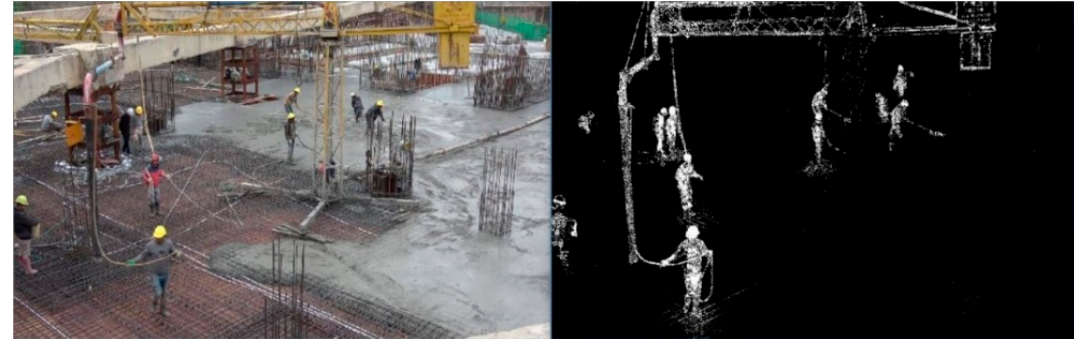
Figure 5. Moving object detection.